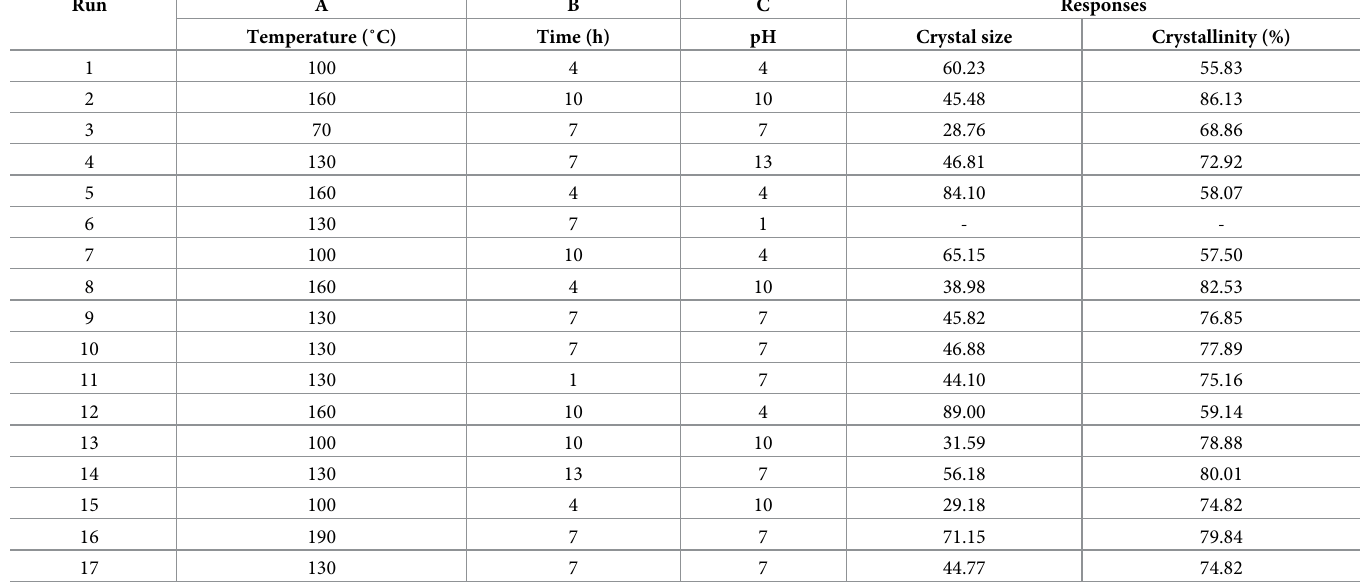
Table 3. XRD results for 17 sample